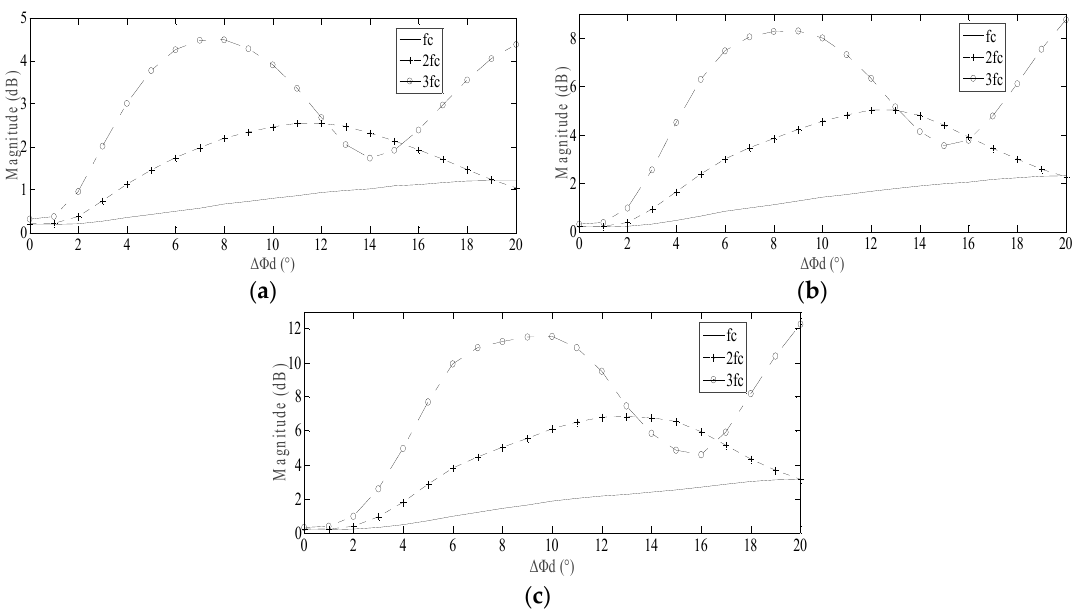
Figure 8. Amplitude trends of f c , 2 f c and 3 f c for different spall lengths when the spall depth is varied respectively: ( a ) Spall depth h d = 20 μ m; ( b ) Spall depth h d = 40 μ m; ( c ) Spall depth h d = 60 μ m.